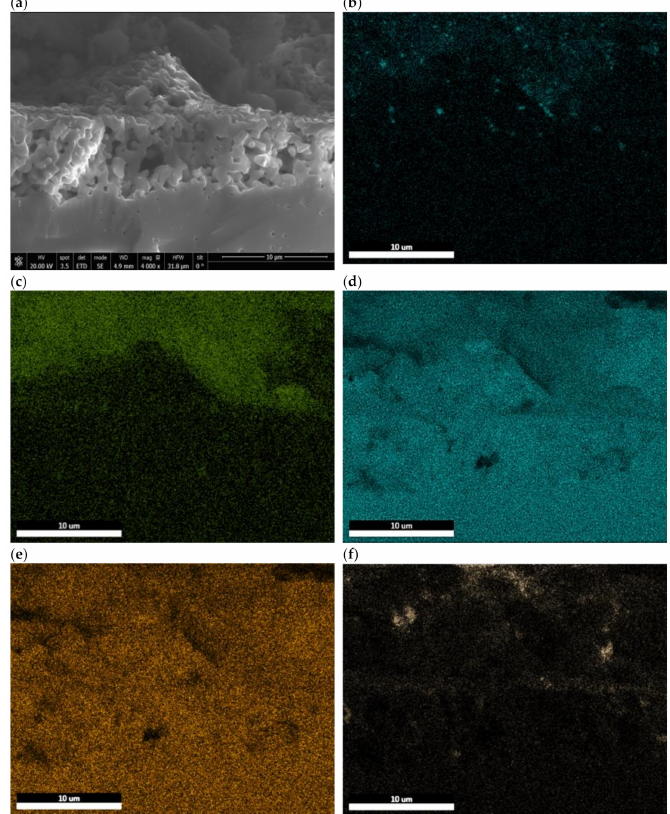
Figure 9. ( a ) SEM micrographs of the anode / electrolyte interface and elemental mapping of the anode / electrolyte interface ( b ) Ni, ( c ) Ce, ( d ) Zr, ( e ) Y, and ( f ) C after long-term tests in wet and dry CH 4 at 850 ◦